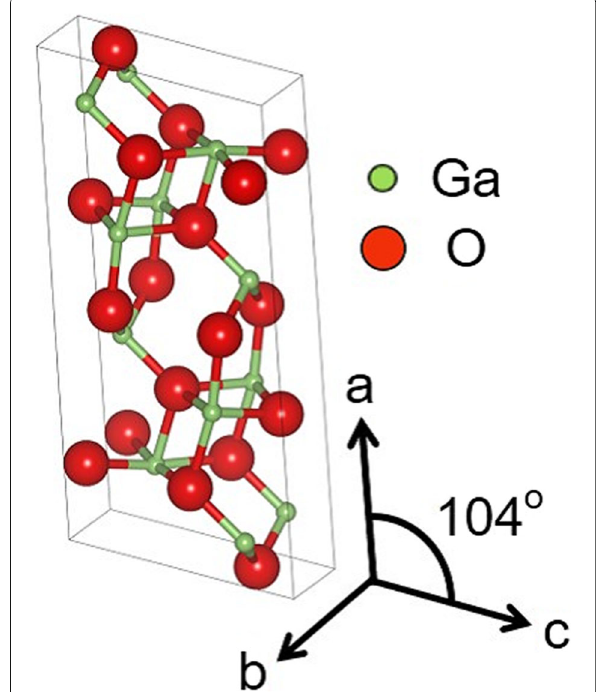
Fig. 2 Atomic unit cell of β -Ga 2 O